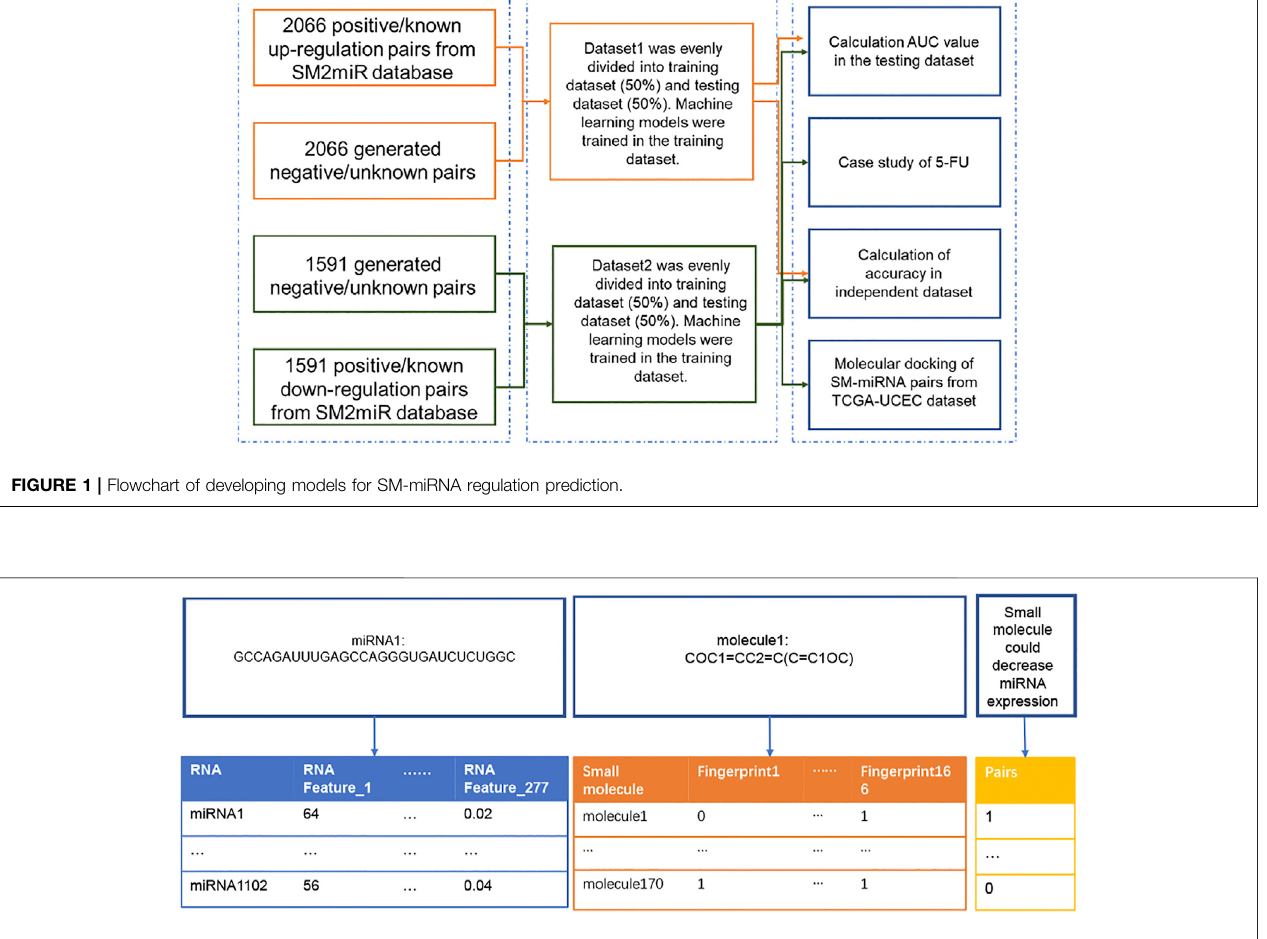
FIGURE2| Construction ofdescriptorsofmiRNAsandsmallmolecules.Thetable inbluepresentsavectorof277RNAfeatures(i.e . ,descriptors)foreach miRNA sequence. For example, RNA Feature_1 represents the length of a miRNA sequence, and RNA Festure_277 represents the frequency of ‘ UUUU ’ in the miRNA sequence. The tablein orange presents a vector of166 fi ngerprints transformed from the SMILES string of each smallmolecule. “ 0 ” and “ 1 ” represent the absence and presence of a substructure in each small molecule, respectively. The table in yellow presents the ‘ 0 ’ and “ 1 ” labels for negative (not binding) and positive (binding) regulation pairs of miRNAs and small molecules,